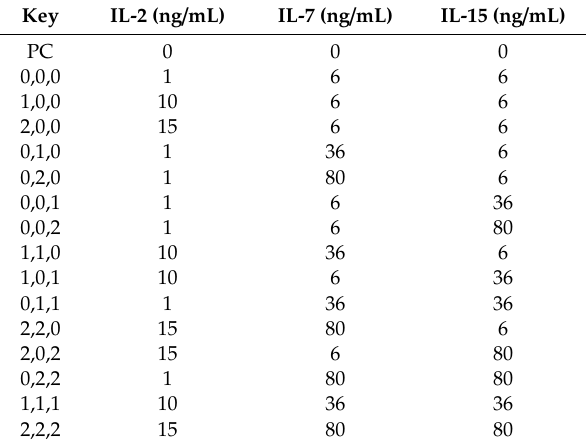
Table 2. The keys and concentrations of IL-2, IL-7 and IL-15 used in the experiments. Experimental concentrations were chosen from literature precedent and refined from initial growth studies and modeling results.